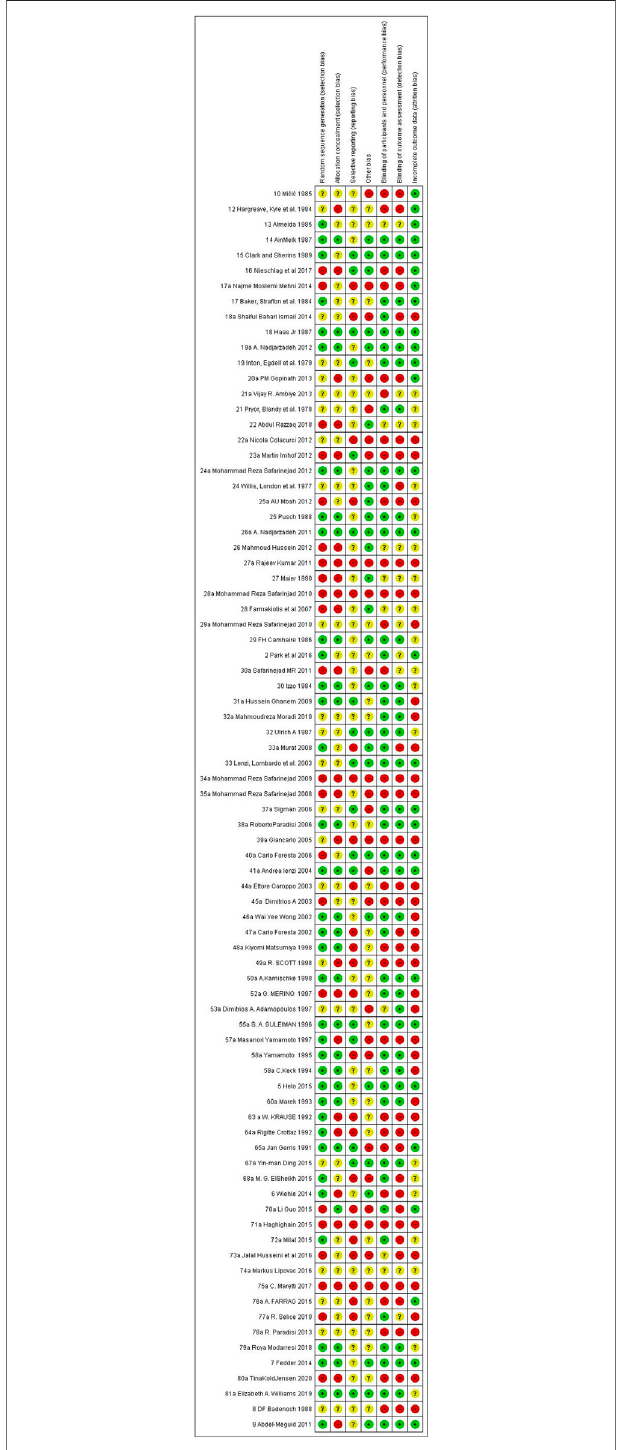
FIGURE 3 | Summary of risk of bias for individual studies.